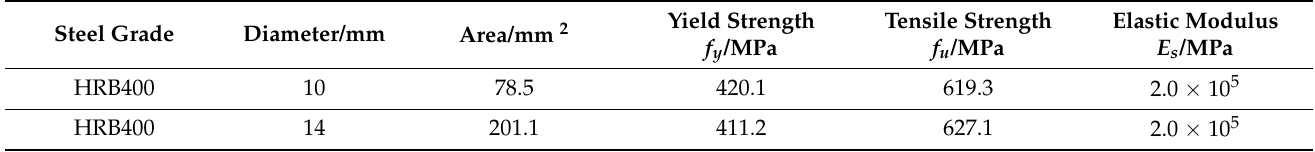
Table 1. The mechanical properties of steel bars.